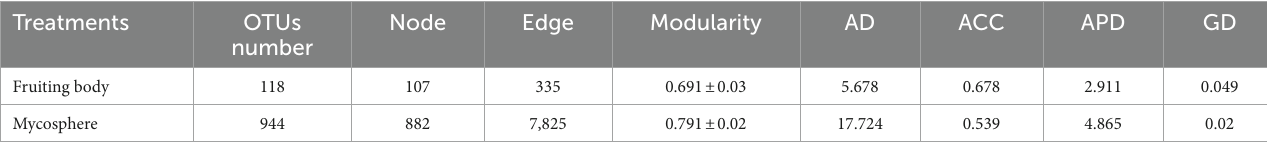
TABLE 1 Topological features of bacterial co-occurrence network in the fruiting body and mycosphere. Treatments OTUs number